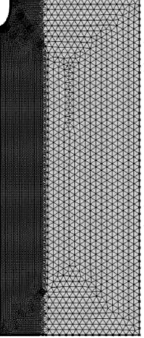
Figure 2. Meshing of the computational domain.